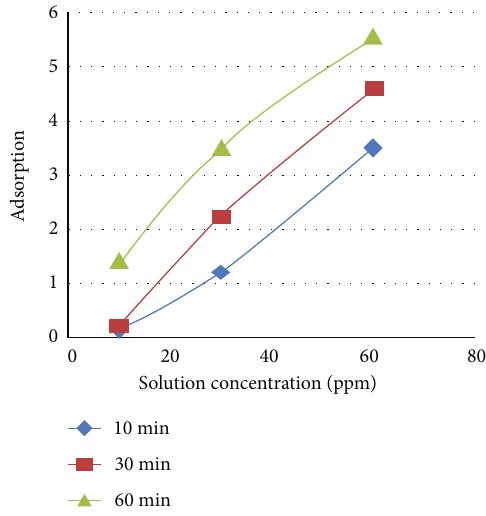
Figure 3: The relationship of concentrations of solutions with adsorption for di ff erent times at the pH